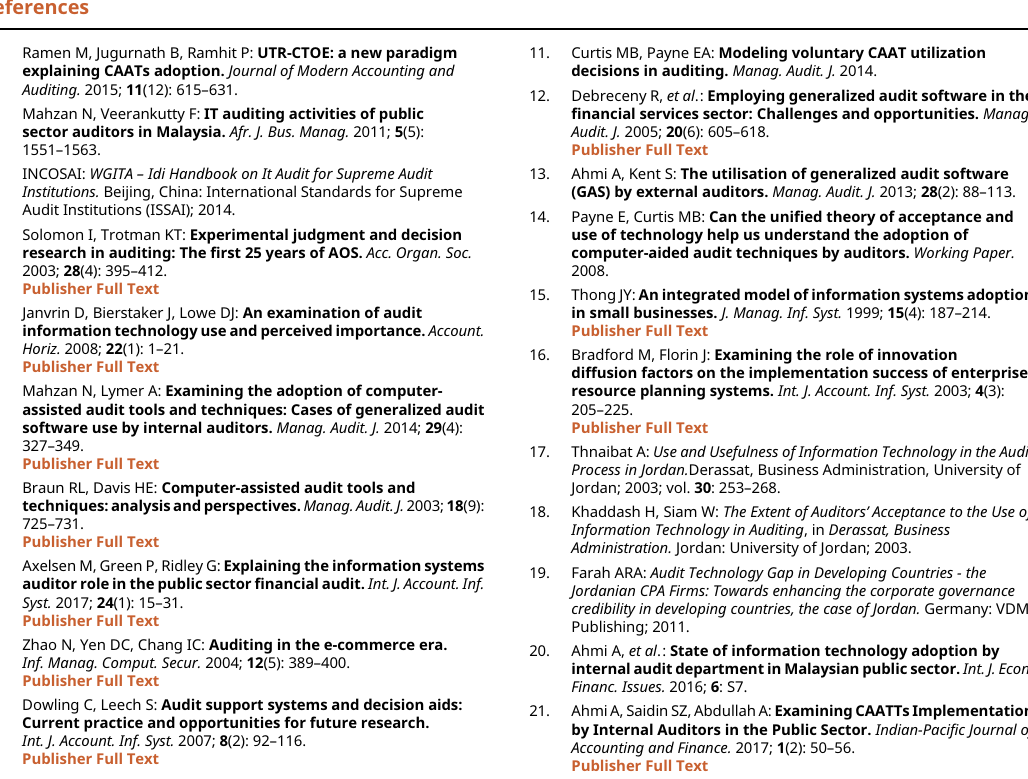
Figshare: The Respondent characteristics of the Modelling Computer Assisted Audit Techniques (CAATs) in Enhancing Indonesian Public Sector, https://doi.org/10.6084/m9.figshare.19642425.v2. 73 This project contains the following extended